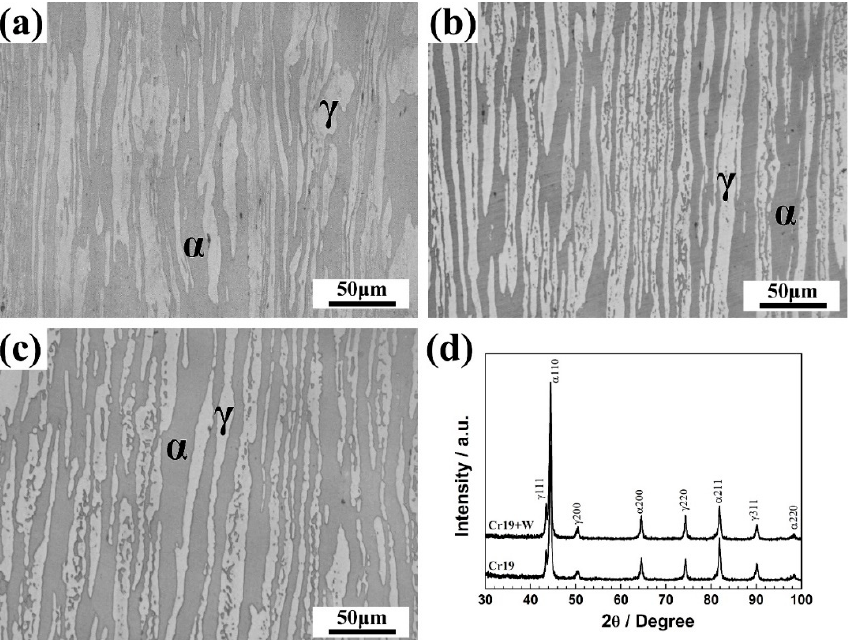
Figure 4. Typical optical micrographs of α + γ phases by optical microscope and corresponding XRD patterns of Cr19 series DSSs, ( a ) Cr19, 900 °C, ( b ) Cr19, 1050 °C, ( c ) Cr19, 1150 °C, and ( d ) Cr19 and Cr19 + W, 1050 °C.